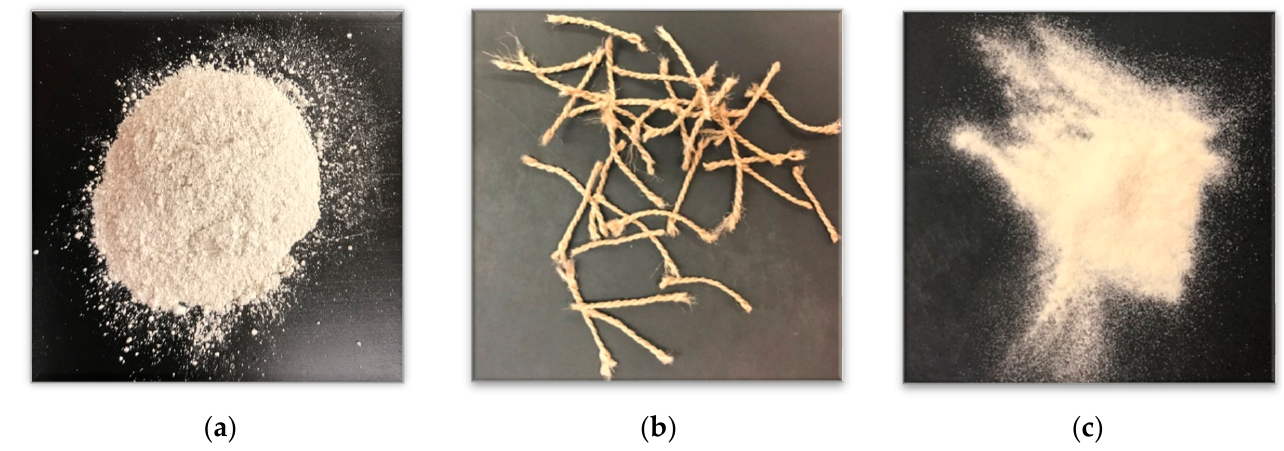
Figure 1. Photos of ( a ) dry kaolinite clay; ( b ) recycled carpet fibers; and ( c ) xanthan gum.